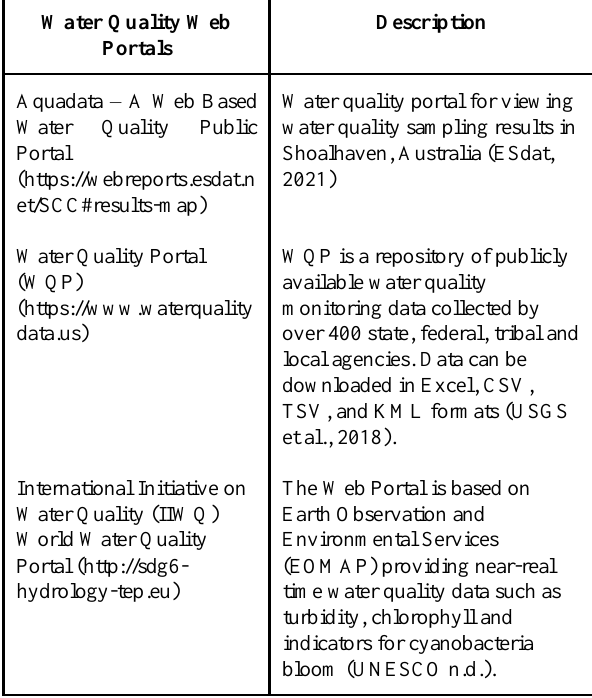
Table 1 . Examples of Web Portals for water quality monitoring data.